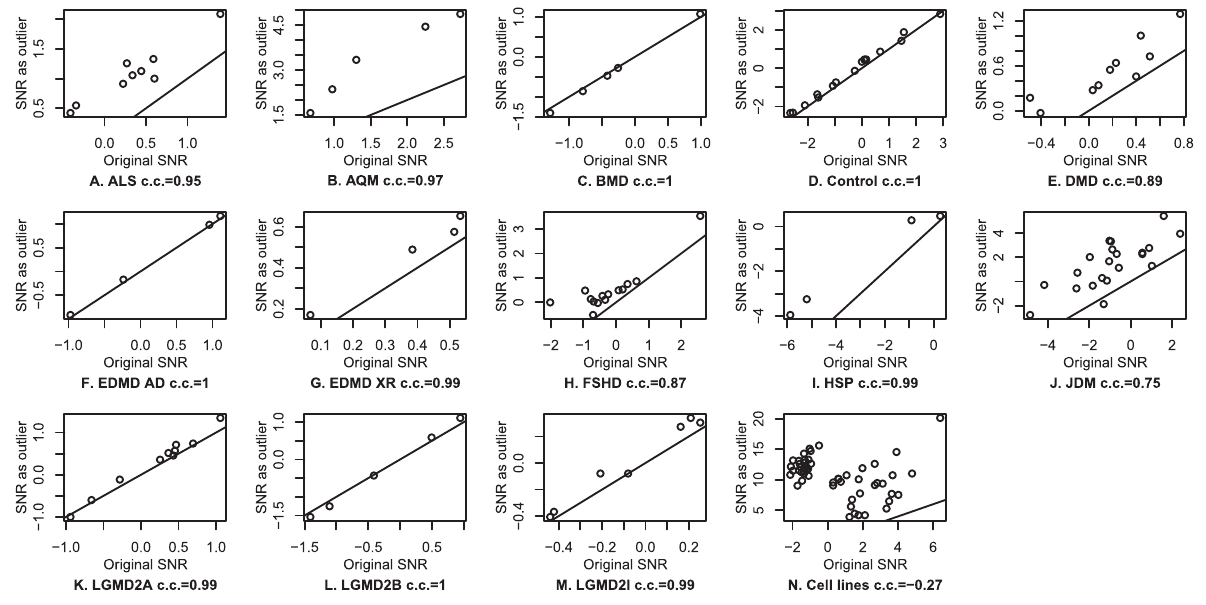
Figure 6. SNR of samples as biological outliers. The SNR of the samples within the complete study (x-axis) are compared with their SNR when removing all similar samples (y-axis). A–M. Muscle diseases, N. Cell lines vs. normal and diseased tissues.